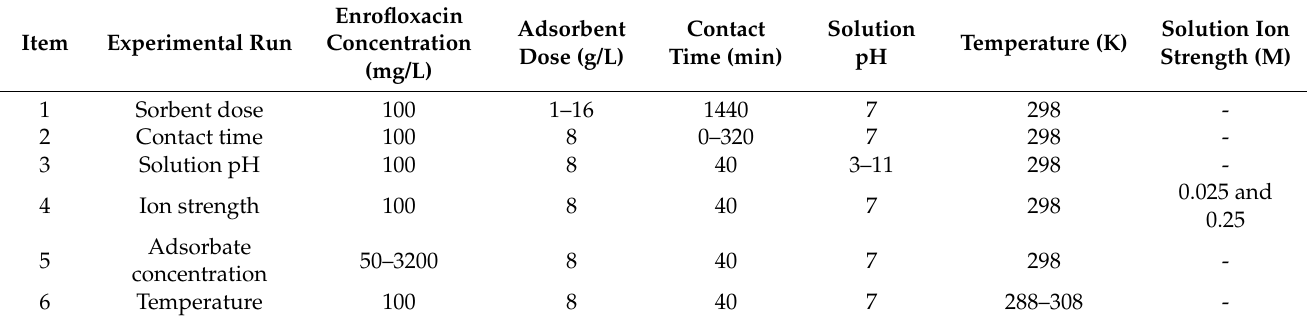
Table 7. The experimental set up for the adsorption of enrofloxacin onto P. koidzumii